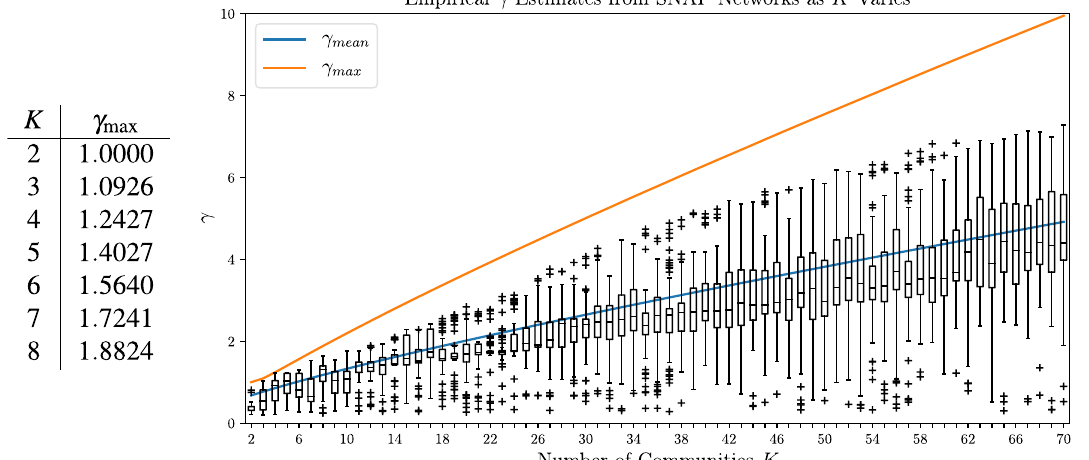
Figure 6. The γ max bound for SBMs of equal-sized blocks compared with observations on 16 social networks (4k–82k nodes, 17k–948k edges) from the Stanford Large Network Dataset 29 . Box plots collect γ estimates for partitions of K communities from 1000 Louvain runs on a γ ∈ [ 0, 10 ] grid on each network. The γ mean estimate (see SI:J) is also plotted for a deterministic map on the finite subset of admissible partitions from CHAMP. The fixed points are then the